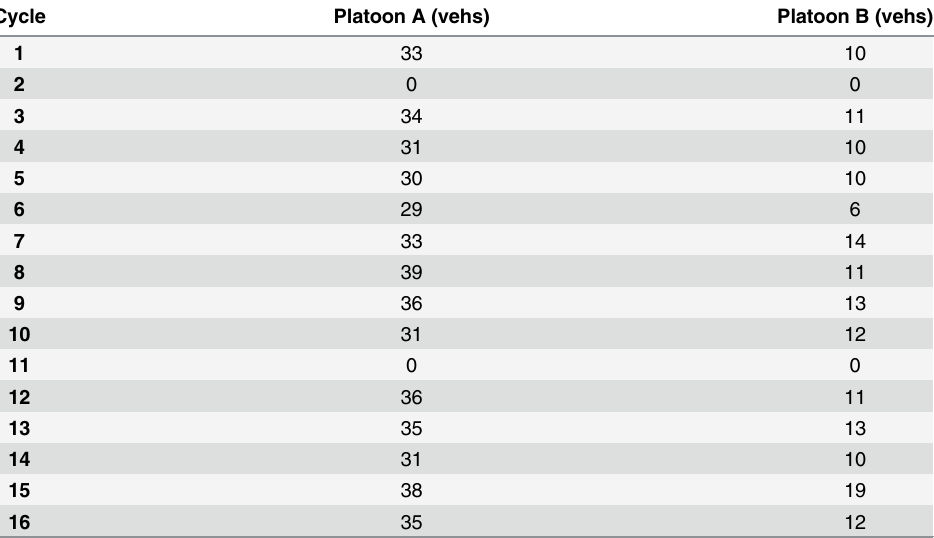
Table 3. Traffic volumes per lane for VCPN.